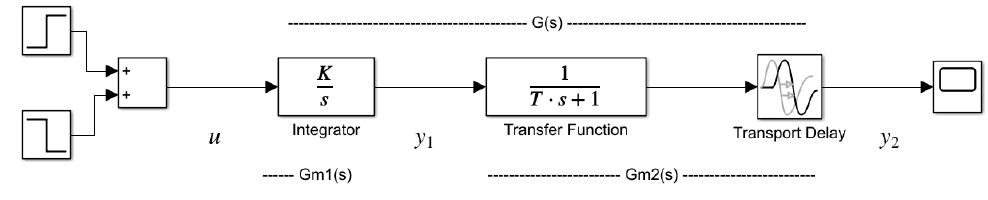
Figure 4. Ideal integrating first-order plus dead-time (IFOPDT) process 𝐺(𝑠)